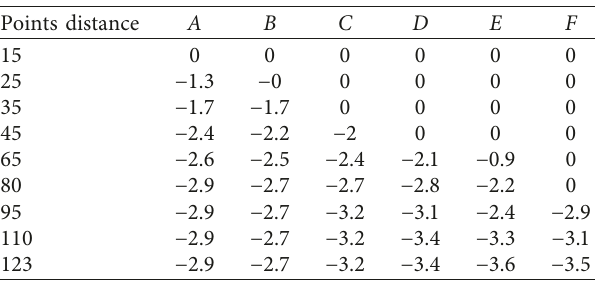
Figure 5: Simulation results. (a) The actual physical simulation model. (b) The model status after coal seam excavation. Table 5: Settlement of measuring points.